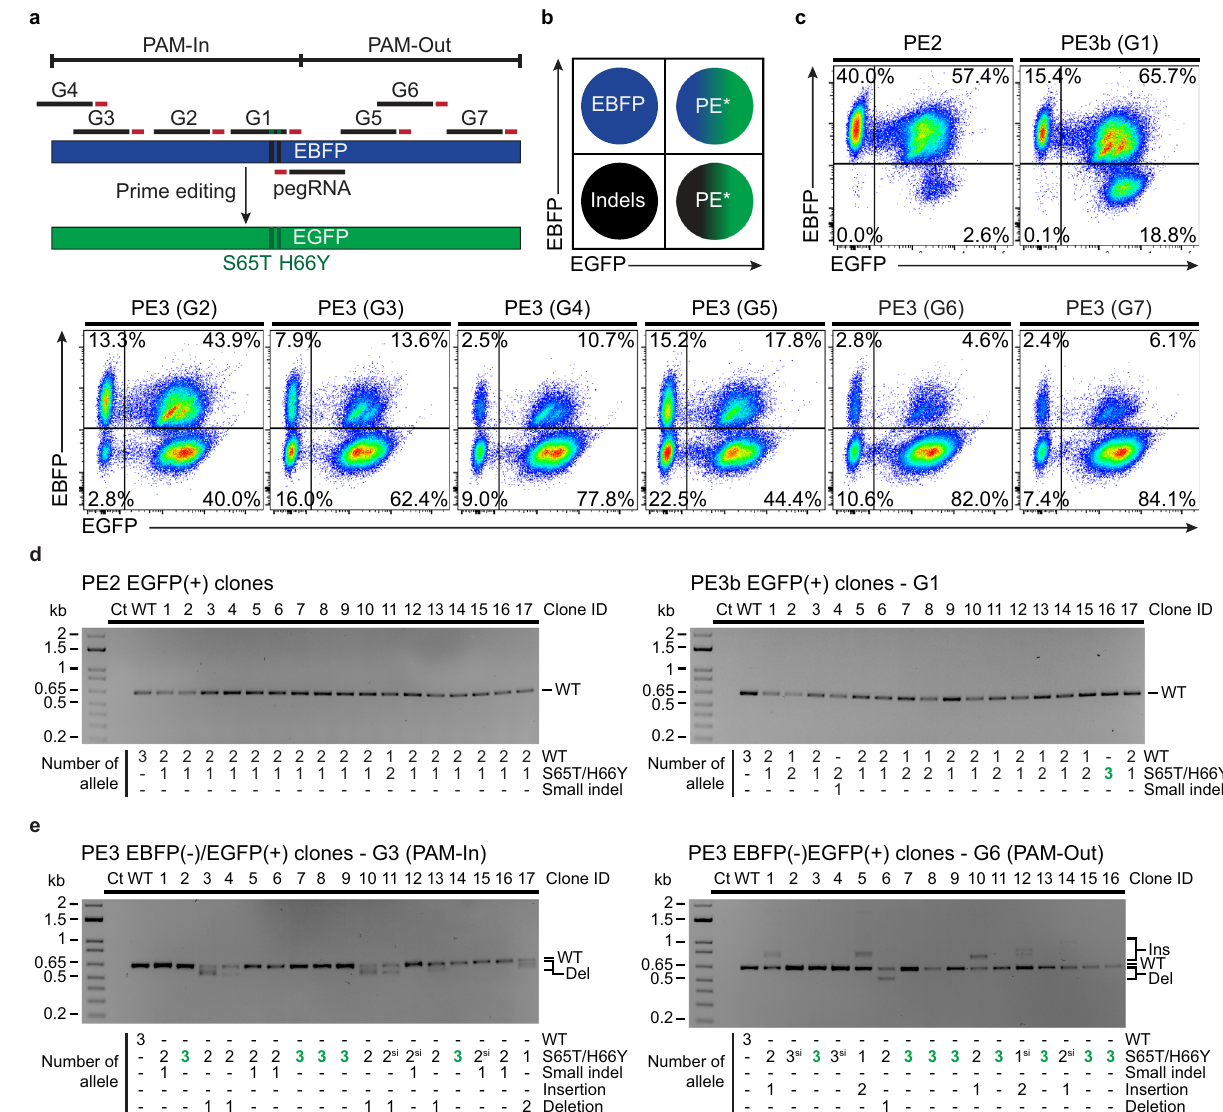
Fig.6|Assessingtheimpactofcomplementary-strandnicklocationsonprime editing outcomes. a Schematic representation of the EBFP to EGFP reporter sys- tem using different nick sgRNAs with PAMs facing outwards (PAM-Out) or inwards (PAM-In) towards the pegRNA. b Schematic of the FACS-based quanti fi cation of EBFP to EGFP conversion via PE. In K562 cells homozygous for EBFP integration at ATP1A1 (triallelic),FACS-basedanalysisreportsPEoutcomesindirectly;(i)EBFP(+)/ EGFP(+) cells result from monoallelic or biallelic PE, (ii) EBFP( − )/EGFP(+) cells are generated by either triallelic PE or combinations of mono- and biallelic PE along with indels*, (iii) EBFP( − )/EGFP( − ) occur from indels on the three copies of the reporter. Indels are de fi ned broadly in thiscontextasany edits that inactivates the reporter. c FACS-based quanti fi cation of EBFP to EGFP conversion via PE after co- selection. K562 cells stably expressing the EBFP reporter from the ATP1A1 locus weretransfectedwithPE3maxvectorstargeting ATP1A1 exon4(pegRNA-Q118R_v1) and EBFP (epegRNA). Cells were treated with 100 µ M ouabain starting 3days post- transfection until all non-resistant cells were eliminated. n =3 independent biolo- gical replicates performed at different times with equivalent results